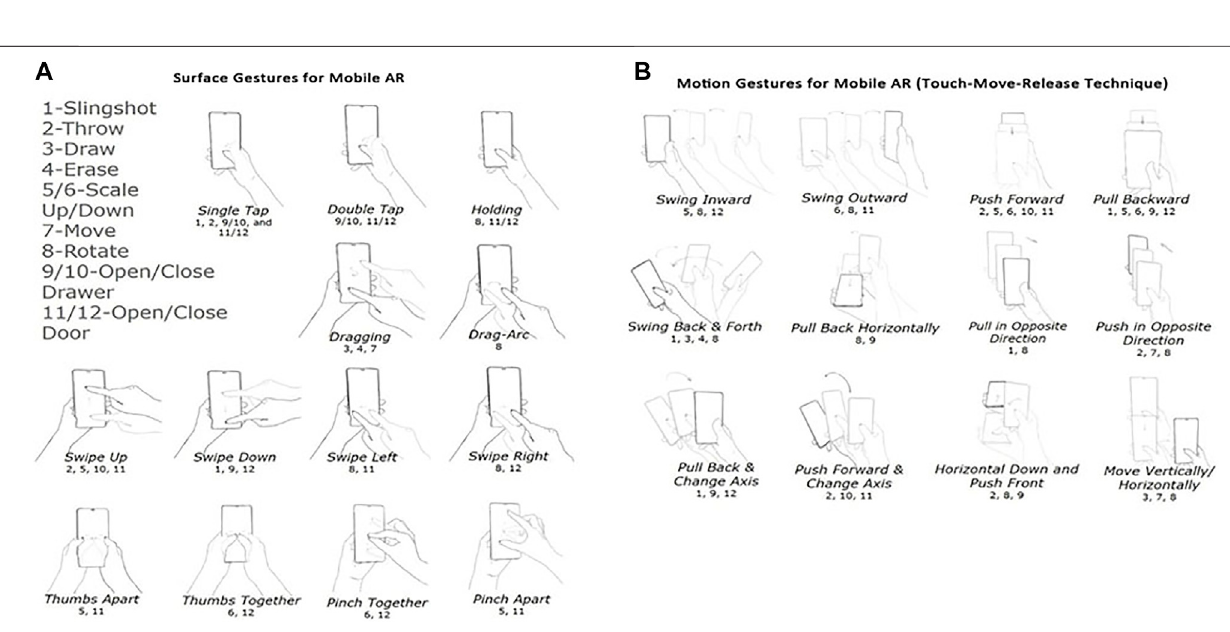
Frontiers in Virtual Reality |